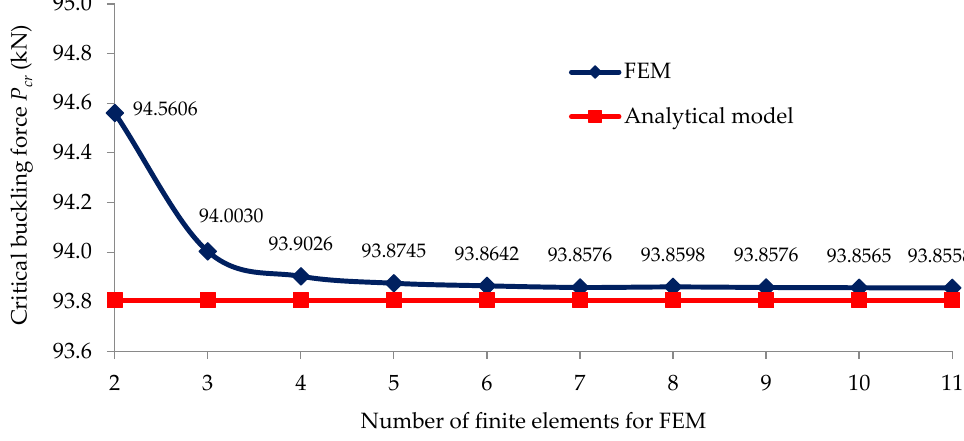
Figure 4. Analysis concerning the convergence of the solution obtained for the critical buckling load by the FEM compared with respect to the value computed with the analytical model.